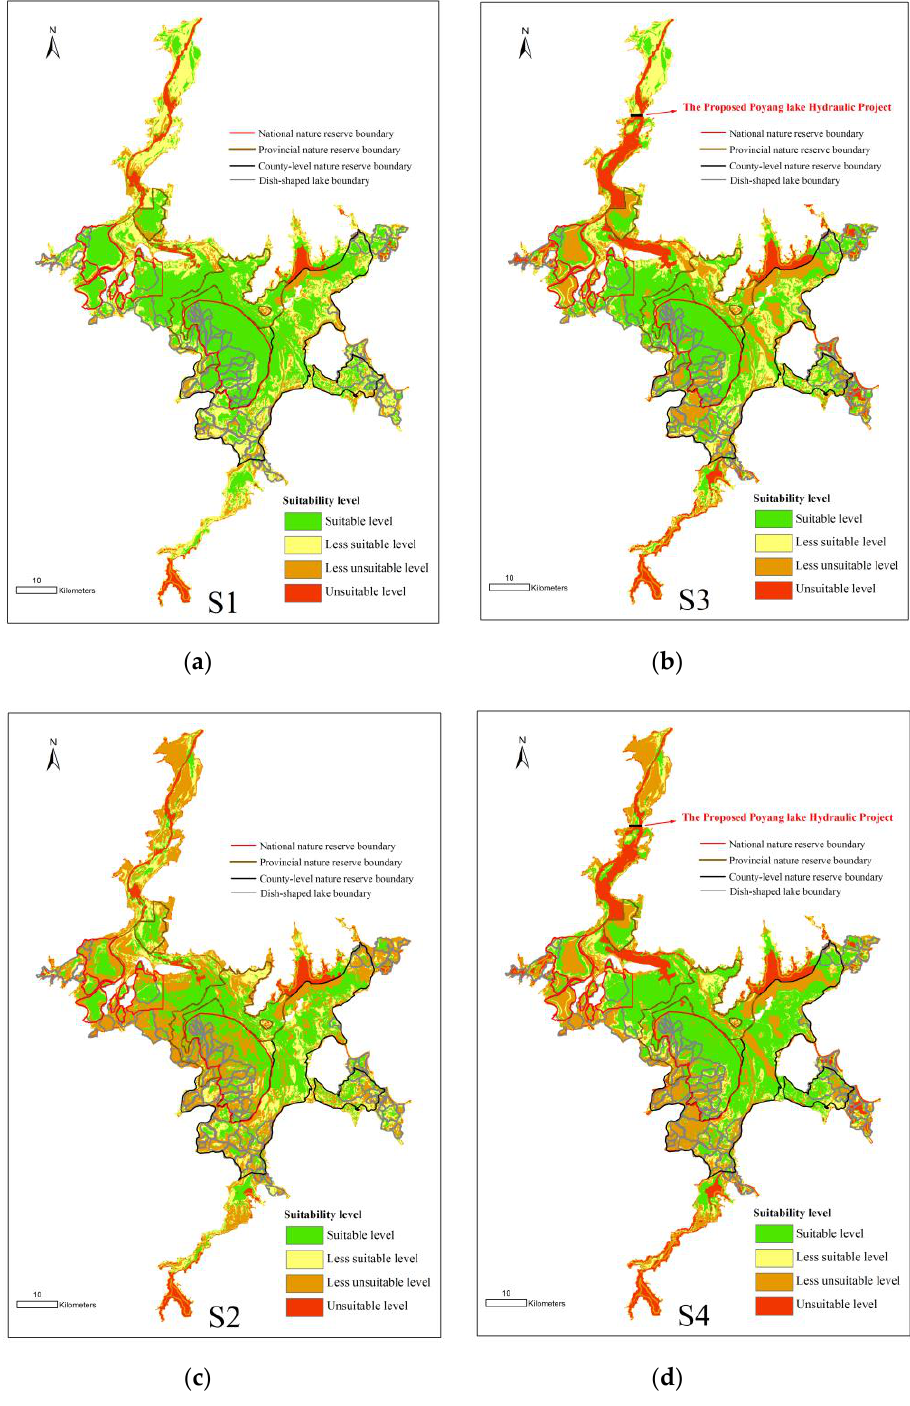
Figure 8. Results of the comprehensive evaluation of habitat suitability for migratory birds. (S1): Wet year, no hydraulic project; (S2): Dry year, no hydraulic project; (S3): Wet year, hydraulic project present / operating; (S4): Dry year, hydraulic project present / operating. ( a ) Suitability distribution for S1; ( b ) suitability distribution for S3; ( c ) suitability distribution for S2; ( d ) suitability distribution for S4.